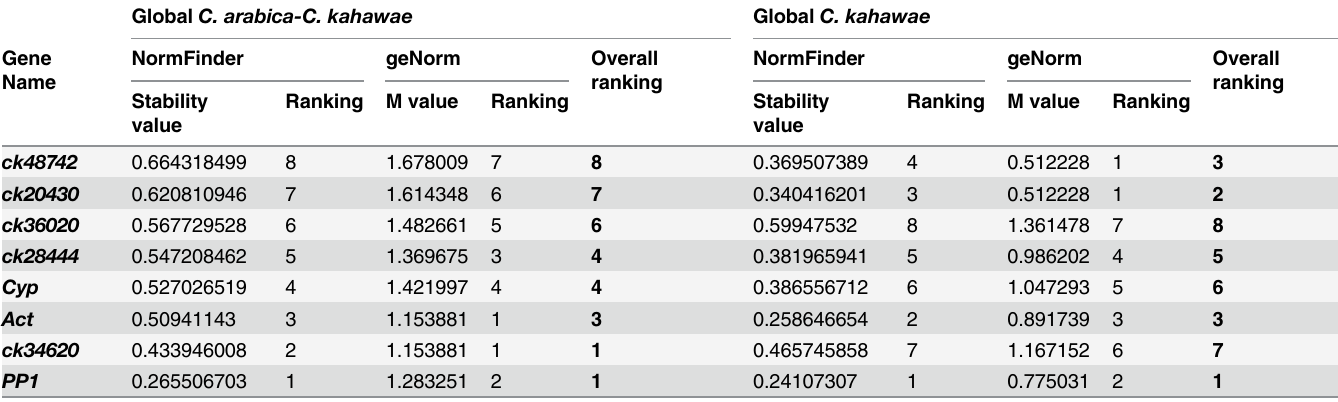
Table 3. Comprehensive ranking of candidate reference genes for each of the datasets used: i) all C . arabica - C . kahawae interaction samples; ii) all C . kahawae samples. Global C. arabica-C.